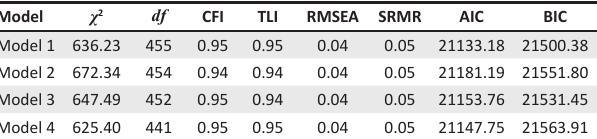
TABLE 1: Fit statistics of competing measurement models. Model